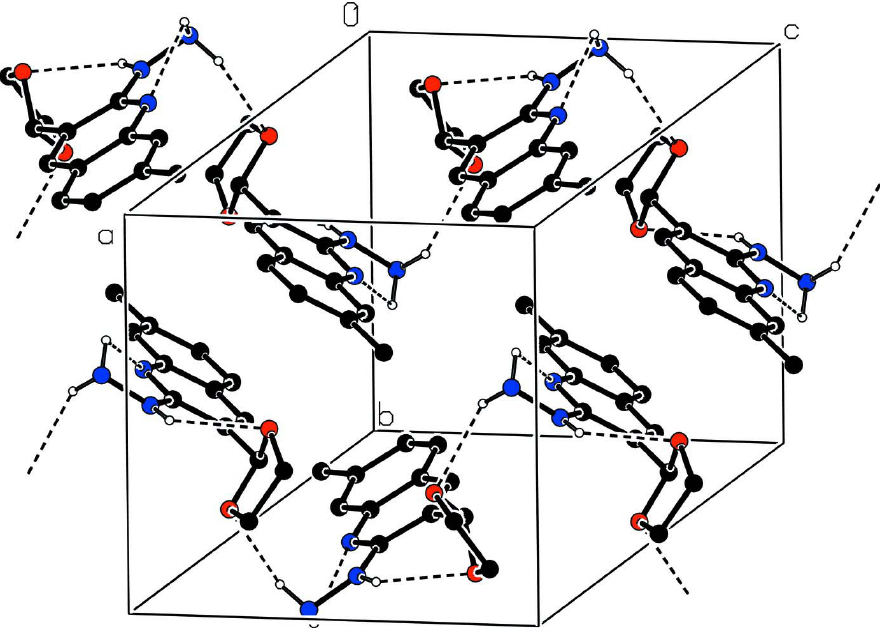
Figure 2 Part of the crystal structure of (I) showing hydrogen bonds as dashed lines. H atoms not involved in hydrogen bonds have been